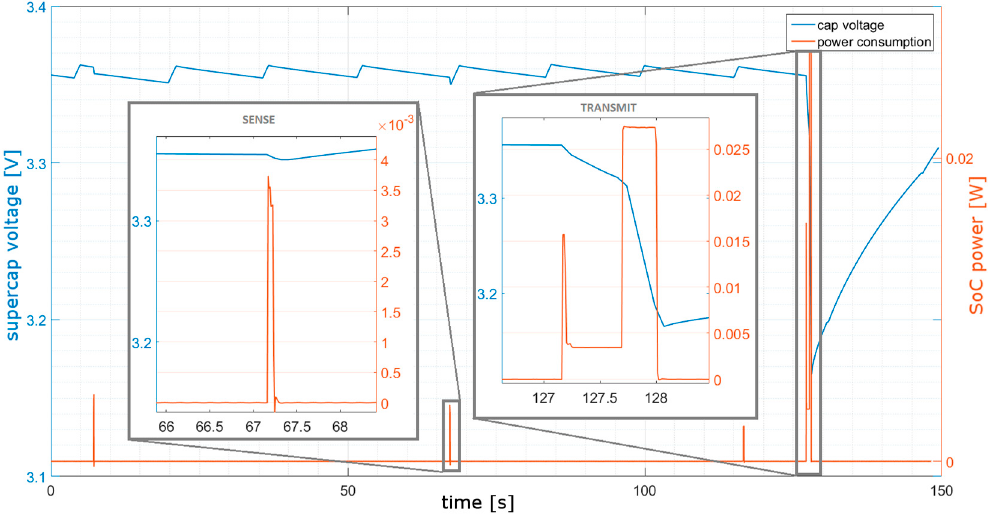
Figure 4. Power profile during a full cycle, sensing and transmitting, left axis shows voltage level of the storage supercapacitor, right axis shows the power consumption (W) of the CC1310 performing